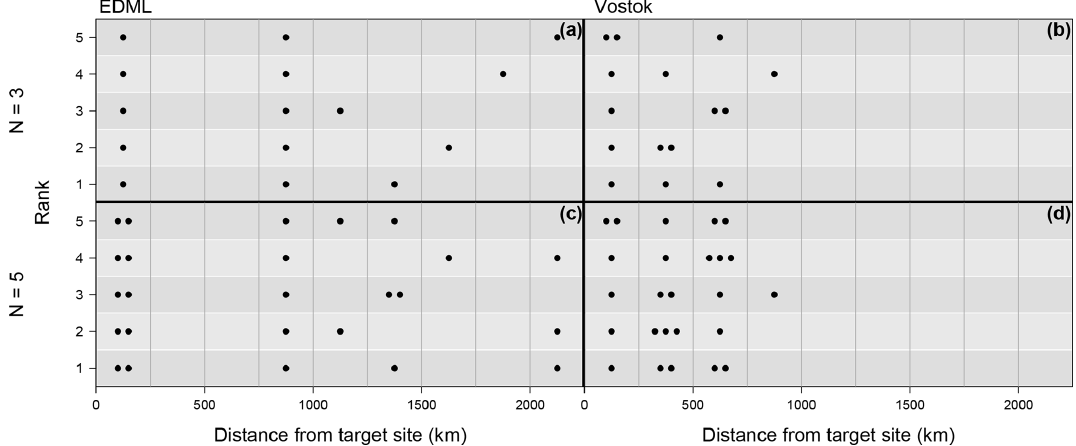
Figure 7. The optimal arrangement for averaging three or five δ 18 O (pw) ice cores to reconstruct the target site temperature at the EDML ( a , c ) and Vostok ( b , d ) drilling sites. Displayed are subsets of the sampling correlation structures for N (cid:96) = 3 and 5, showing along the vertical axis the optimal five of all possible combinations of rings (best denoted as rank 1, fifth best as rank 5), i.e. those which exhibit the five highest mean correlation values across 10 5 random trials of averaging N (cid:96) = 3 ( a , b ) or N (cid:96) = 5 ( c , d ) grid cells from these rings. The ring bin borders are marked by thin vertical lines with their distances from the target site given on the horizontal axes; the selected optimal ring combinations are marked as black dots. Systematically, arrangements which combine ice cores from the innermost ring with ice cores further away are found to be optimal, with larger distances for the EDML target